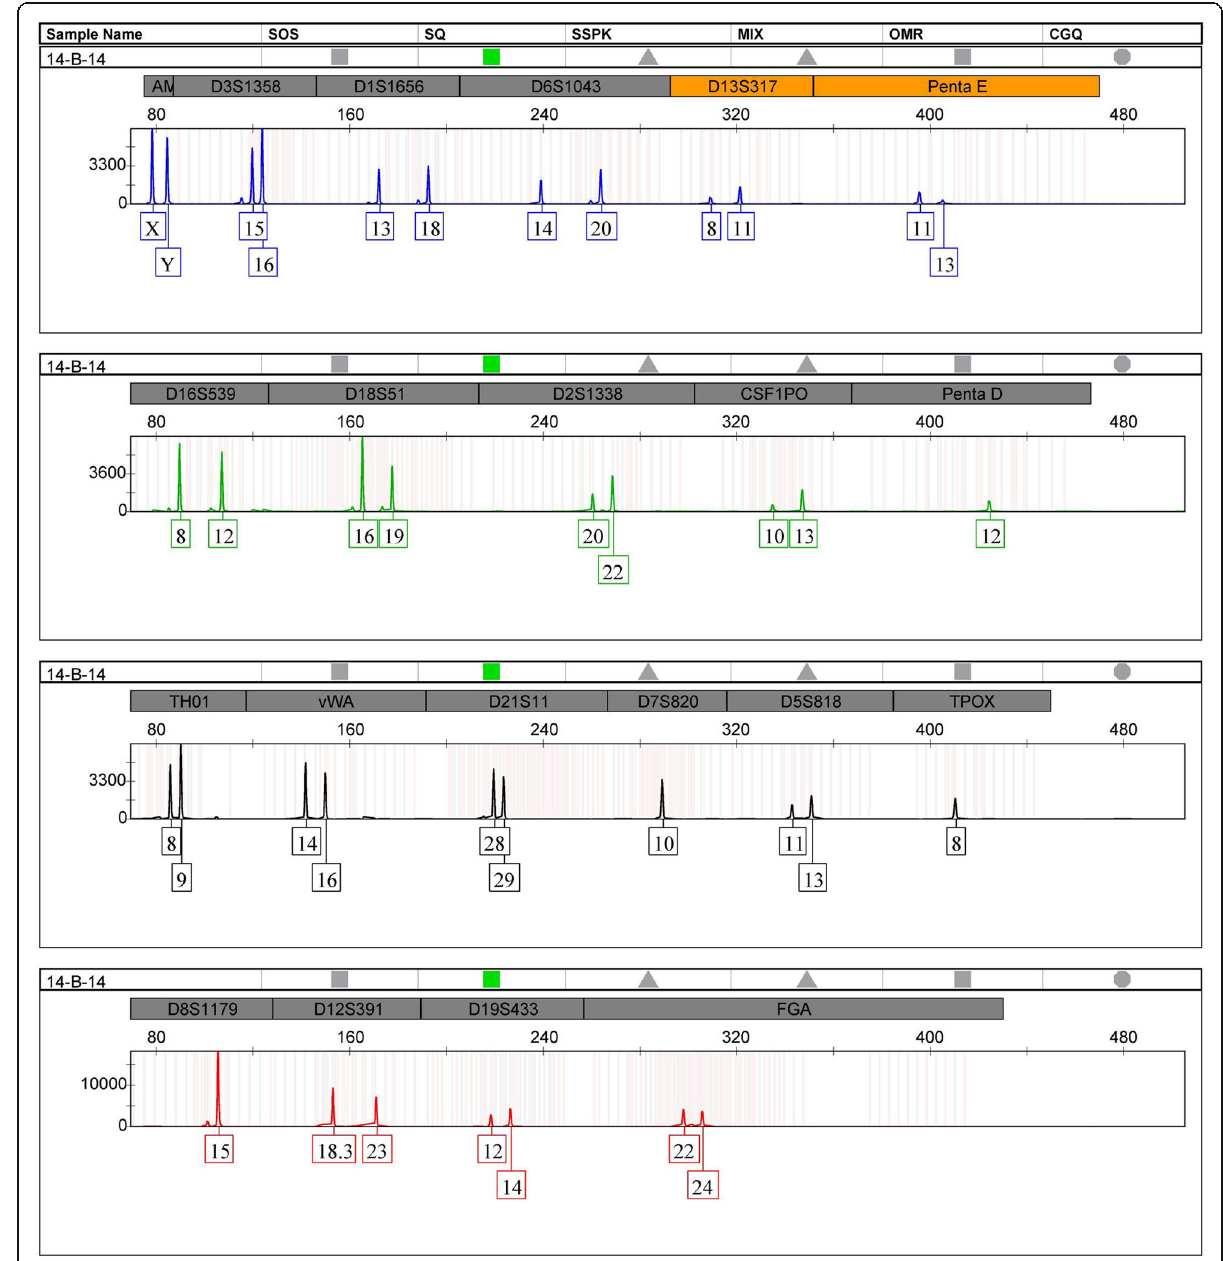
Fig. 1 Electropherogram of brain tissue showing amplification at all 21 loci in the form of allele